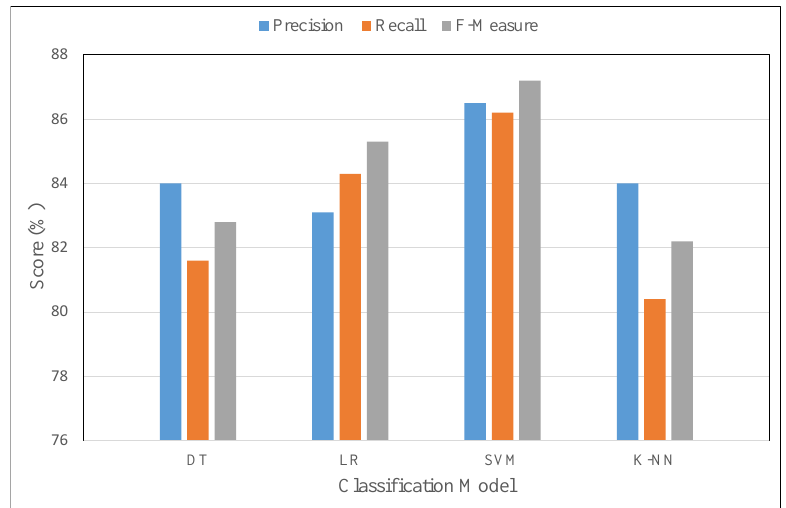
Figure 10. Performance evaluation using different classification models in terms of precision, recall, and